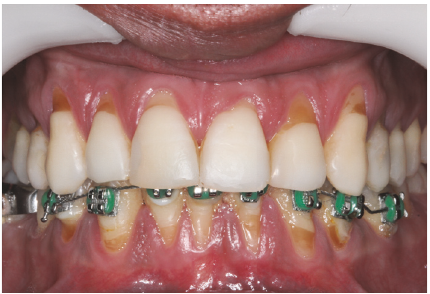
Figure 1: Patient with multiple Miller class II gingival recessions, on the vestibular face of the upper and lower